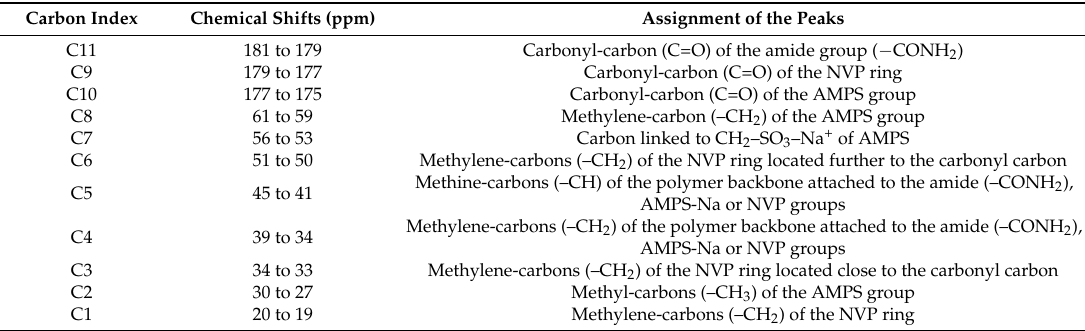
Figure 1. 13 C-NMR spectrum of the 2-acrylamido-2-methylpropane sulfonic acid (AMPS) – N -vinyl-2-pyrrolidone (NVP)–acrylamide terpolymer. Table 1. Assignment of the chemical shift of the carbons of the polymer sample.